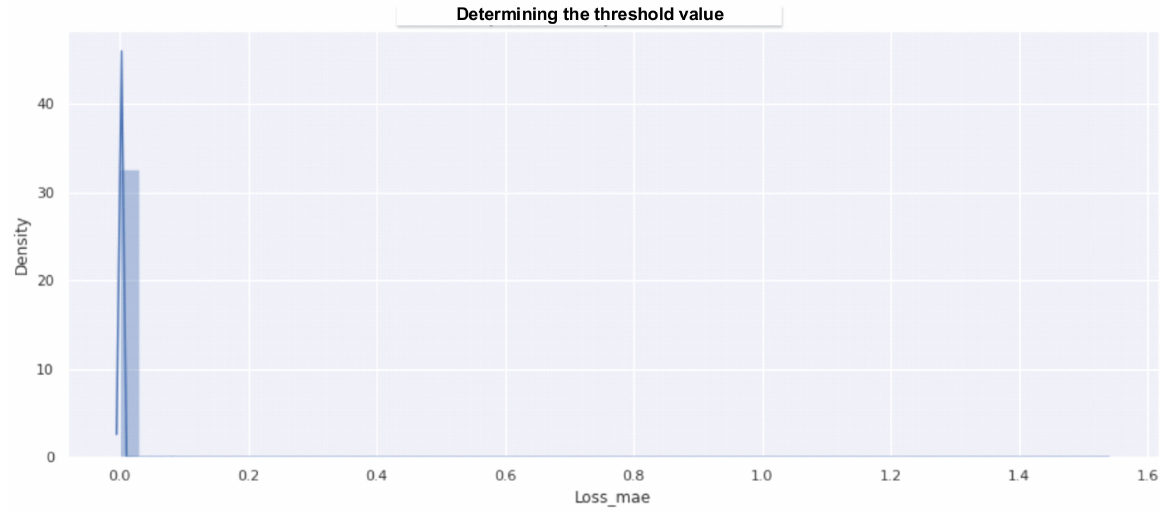
Figure 28. Distribution of learning